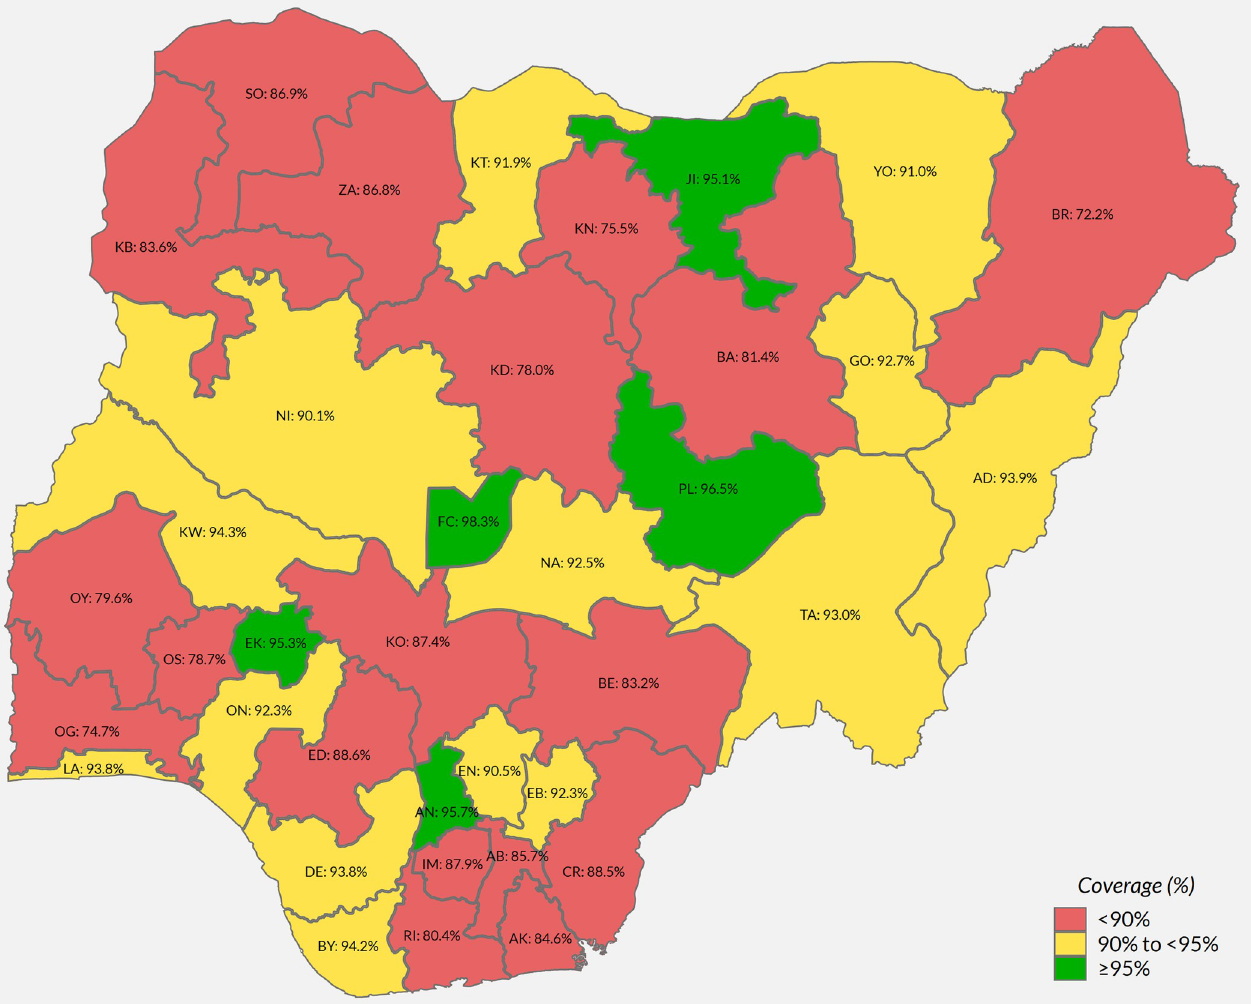
Fig 3. Weighted percentage of children 9 to 59 months vaccinated during the 2017–18 measles SIA, by state.